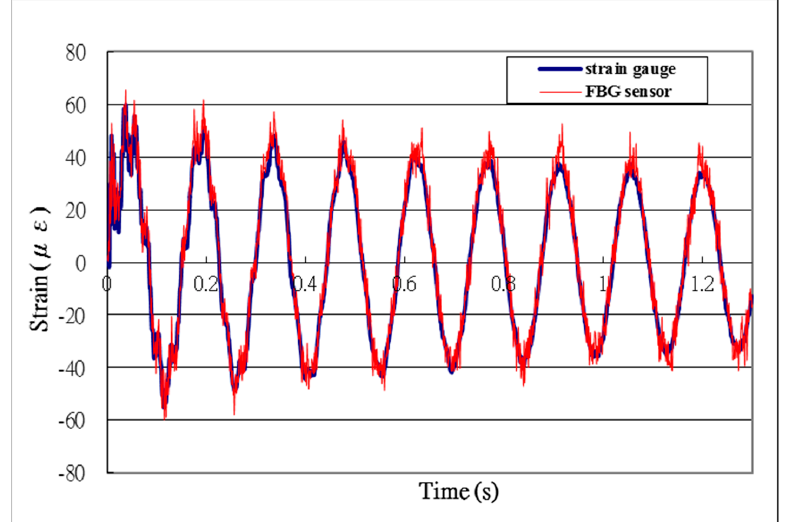
Figure 12. Transient response of a cantilever beam subjected to impact loading.